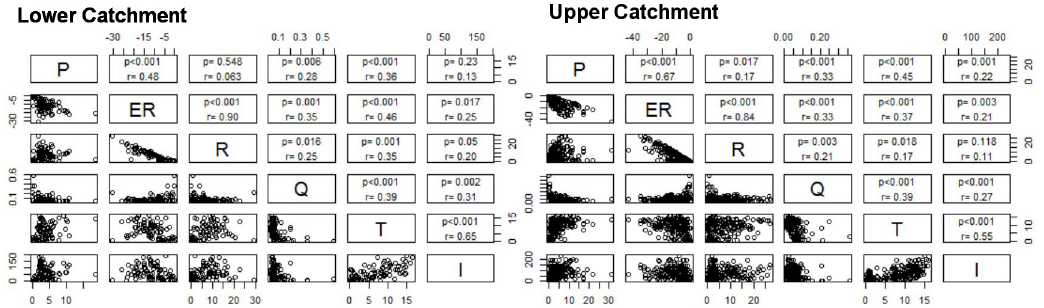
Fig 8. Bivariate plots of daily gross primary productivity (GPP), respiration (ER), re-aeration (RC), discharge (Q), water temperature (T) and incoming shortwave radiation (I) from accepted models for both the upper catchment (right) and the lower catchment (left). r = correlation coefficient, p = significance